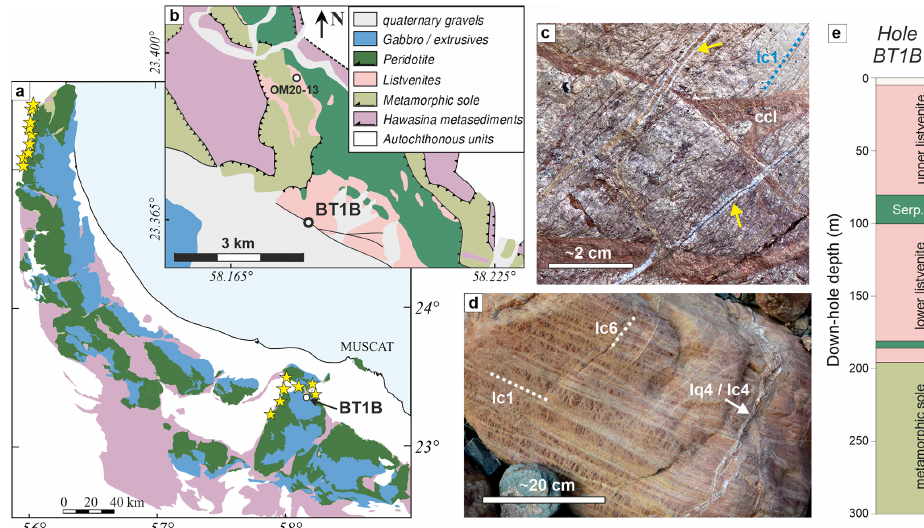
Figure 1. Geological overview map of the Samail ophiolite (common legend in b ), with locations of known listvenite occurrences (yellow stars) (after Nicolas and Boudier, 1995). (b) Detailed geological overview of the area surrounding site BT1 (after de Obeso et al., 2022, and Villey et al., 1986); (c) Vein generations in outcrop, with closely spaced narrow carbonate veins (lc1, blue dotted line) cut by cataclasite (ccl, brown–red) and quartz–carbonate veins (yellow arrows). (d) Different vein generations in listvenite boulder with exceptionally wide veins, with the vein network in the matrix resembling a mesh cut by closely spaced parallel carbonate (lc1) and later quartz–carbonate (lq4 and lc4) and dolomite veins (lc6). (e) Lithologies in Hole BT1B (Kelemen et al.,